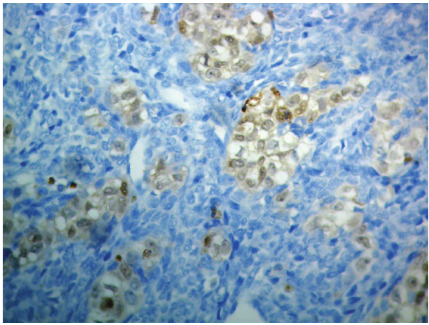
Figure 5: Groups of tumor cells show positive nuclear and cytoplas- mic immunostaining for calretinin (DAB, Haematoxylin ×